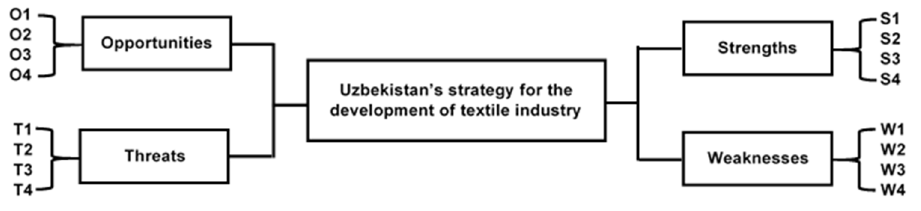
Figure 3. Model of the SWOT–AHP analysis [21].